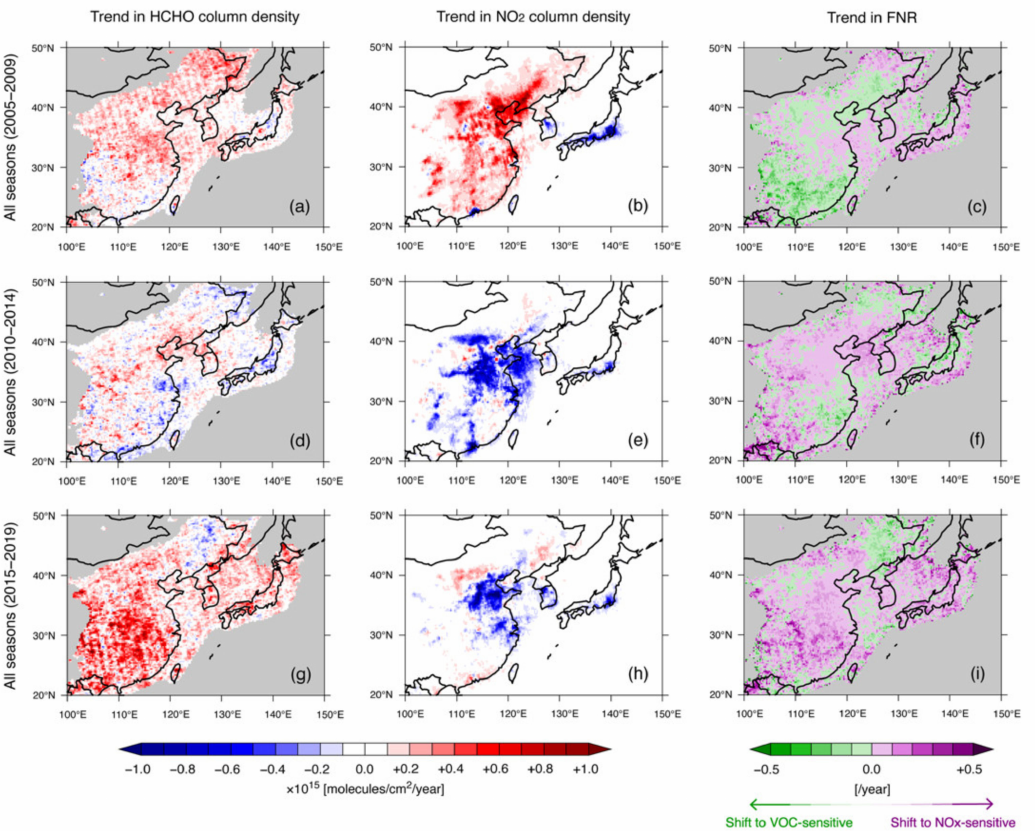
Figure 3. Linear regression analyses for ( a , d , g ) HCHO column density, ( b , e , h ) NO 2 column density, and ( c , f , i ) FNR over East Asia during the 5-year periods of ( a – c ) 2005–2009, ( d – f ) 2010–2014, and ( g – i ) 2015–2019 averaged over all seasons. HCHO column density and FNR are analyzed at grid points where NO 2 column density is greater than 1.0 × 10 15 molecules cm − 2